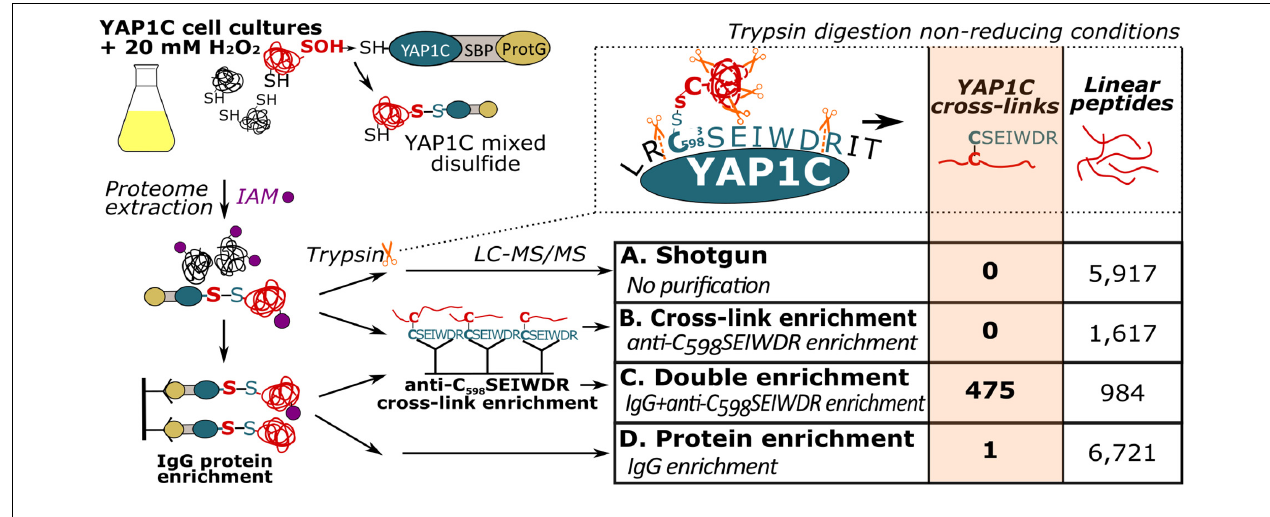
FIGURE 1 | Enrichment strategies for YAP1C cross-linked (CL) peptide identification. Trypsin digestion under non-reducing conditions results in YAP1C C 598 SEIWDR CL peptides containing the redox-active Cys598. Next to a non-enriched proteomic shotgun (sample A), CL peptide enrichment was tested with anti-C 598 SEIWDR polyclonal antibodies (sample B). In addition, YAP1C-interacting protein complexes were purified on IgG-Sepharose beads, followed by an on-bead trypsin digestion (sample D). The obtained peptides were further enriched for C 598 SEIWDR CL peptides on beads coupled to the anti-C 598 SEIWDR antibody (sample C). IAM, iodoacetamide, indicated by purple dots; LC-MS/MS, liquid chromatography-tandem mass spectrometry; ProtG, two IgG-binding domains of protein G; SBP, streptavidin-binding